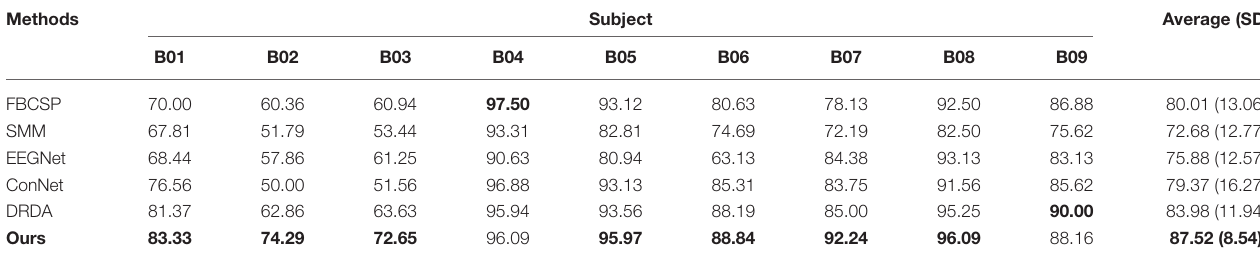
TABLE 4 | Classification accuracies (%) obtained with the dataset BCI competition IV-2b. Methods